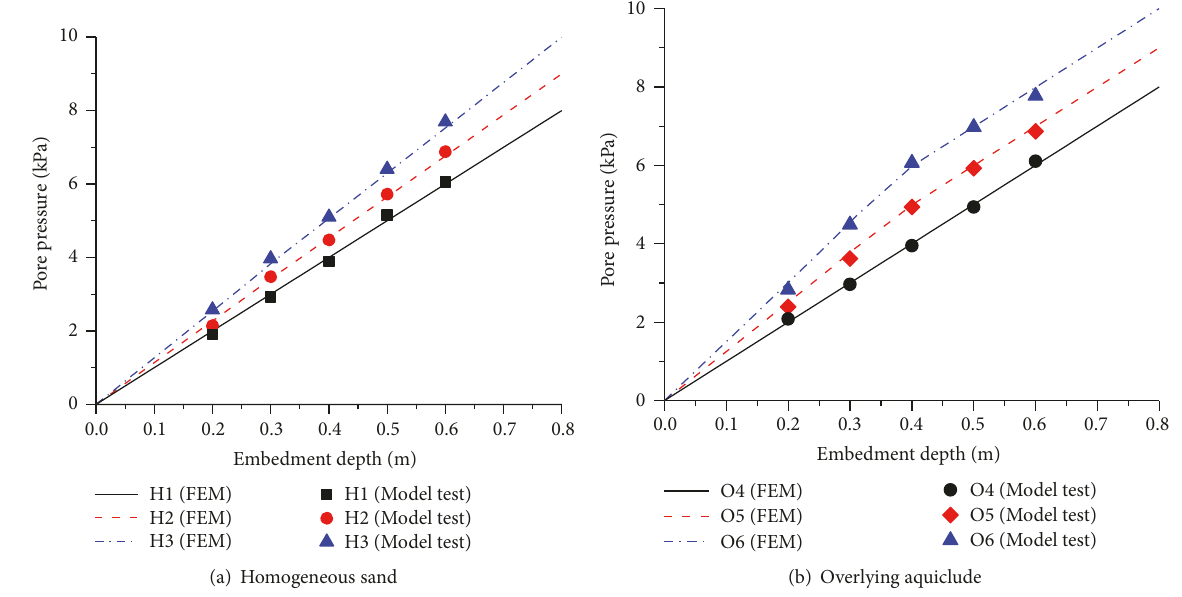
Figure 9: Comparison between measured pore pressure values and finite element results at corner